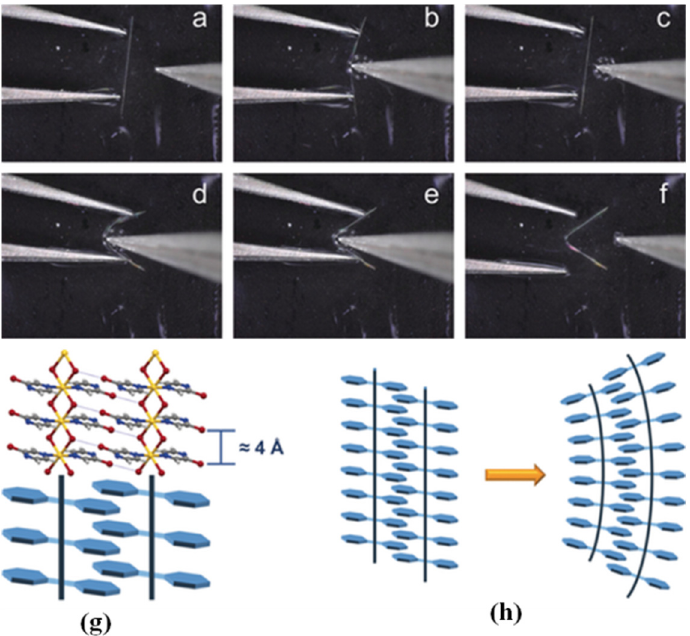
Figure 4. Snapshots of repeated elastic bending motion ( a – c ) of a needle-shaped crystal of [CdBr 2 (Br-pz) 2 ] n . The crystal breaks when it is bent beyond a critical radius ( d – f ). Bending was performed by a pair of tweezers and a needle. ( g ) Crystallographic illustration of Cd (II) coordination polymer with Cd halides as spine and interlinked by 2-halopyrazine. ( h ) Structural model as elastic bending with long range crystal structure retained. Reprinted with permission from Ref. [41]. Copyright 2018, Wiley-VCH Verlag GmbH and Co. KGaA.